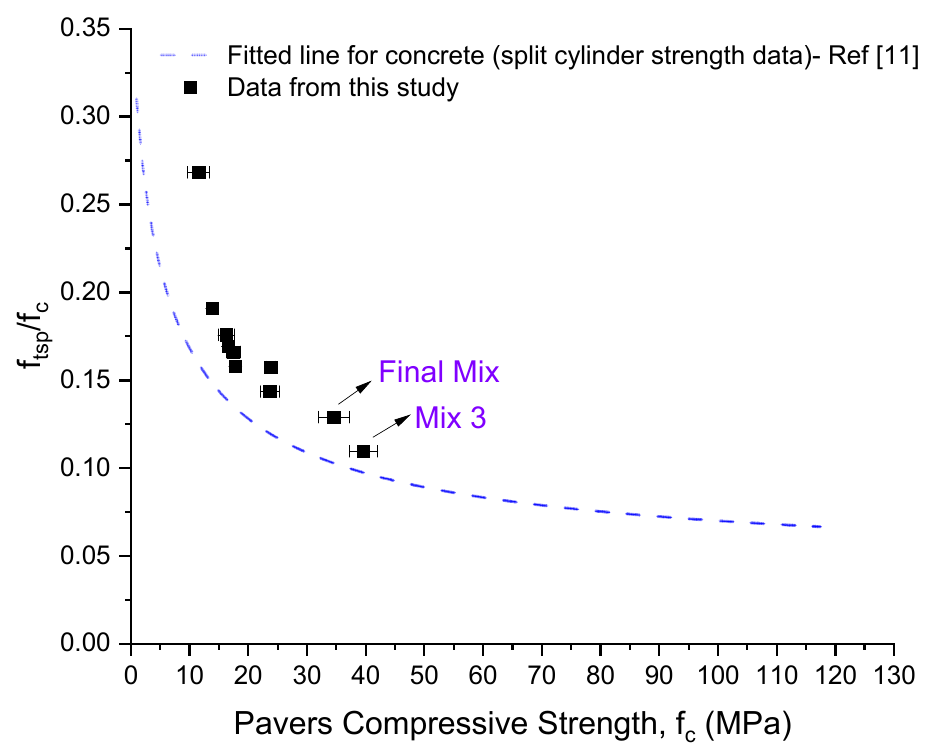
Figure 8. Ratio of splitting tensile to compressive strength versus paver’s compressive strength.